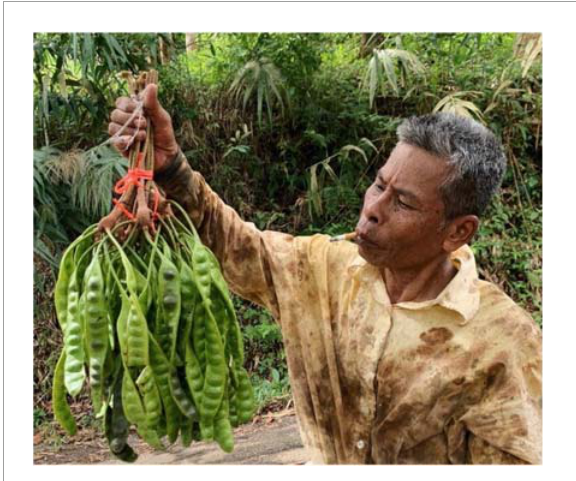
FIGURE5 A. Embong showing off the petai that he acquired by climbing the tree in his kebun . Despite not having much for himself, he insisted on sharing with the researcher in this encounter. Source: Photographed by the first author in Hulu Langat, Selangor, Malaysia, on 18 November